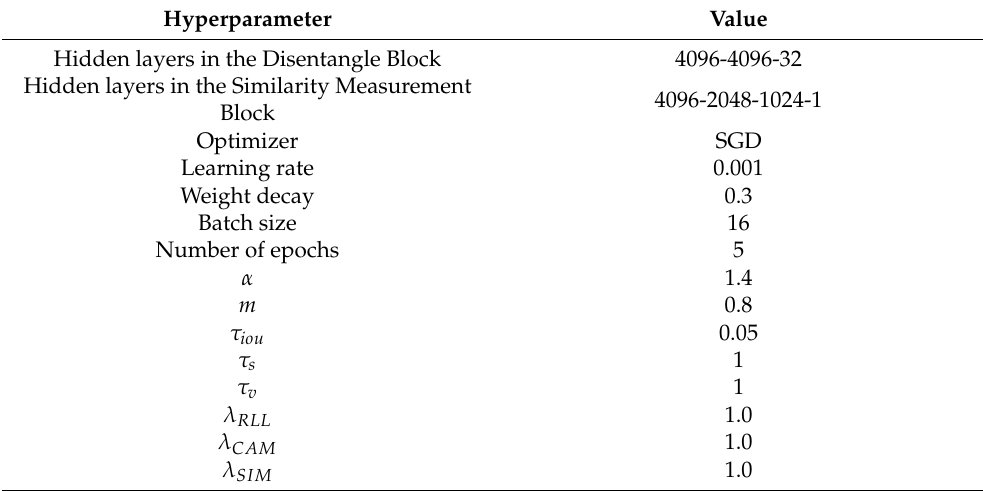
Table 1. Hyperparameter